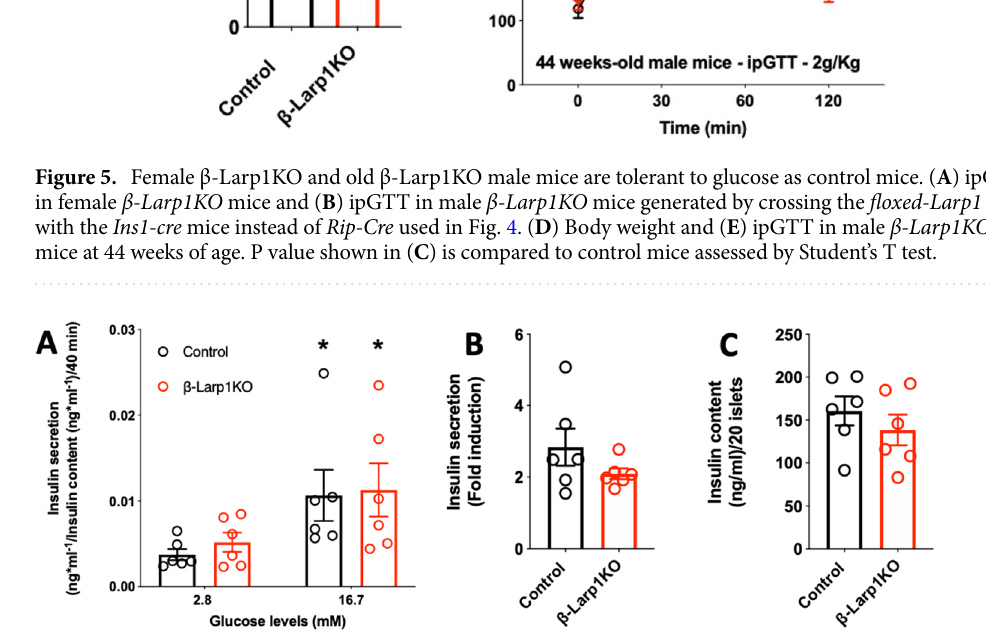
Figure 6. Glucose-stimulated insulin secretion is normal in islets isolated from β-Larp1KO mice. ( A ) Insulin secretion at low and high glucose levels normalized by insulin content; ( B ) fold induction of insulin secretion by high glucose (16.7 mM) normalized to low glucose (2.8 mM) shown in A . ( C ) Insulin content determined in 20 islets. *p < 0.01 compared to 2.8 mM glucose within the group assessed by two-way